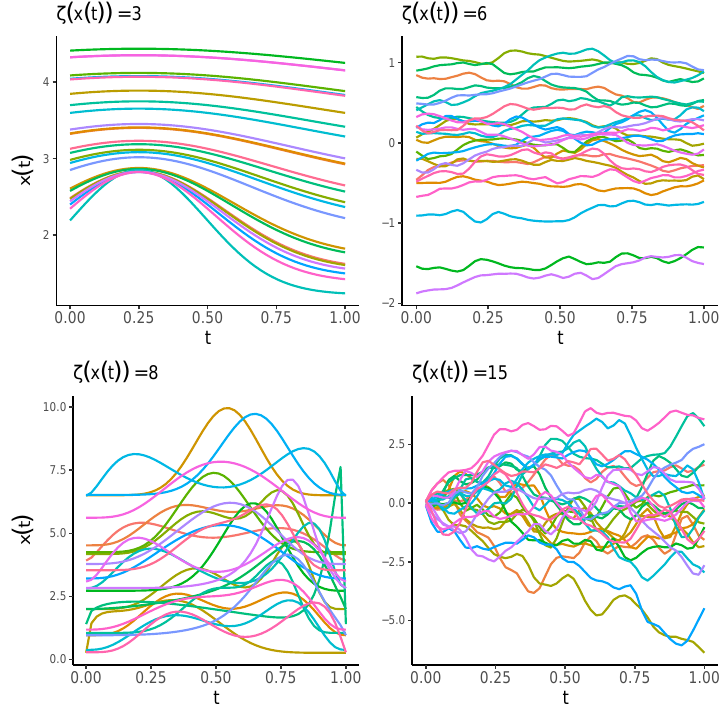
Figure 1. Four different sets of covariate functions of size n = 25 and their respective number of independent pieces of information when the signal-to-noise ratio is 0.10 in model